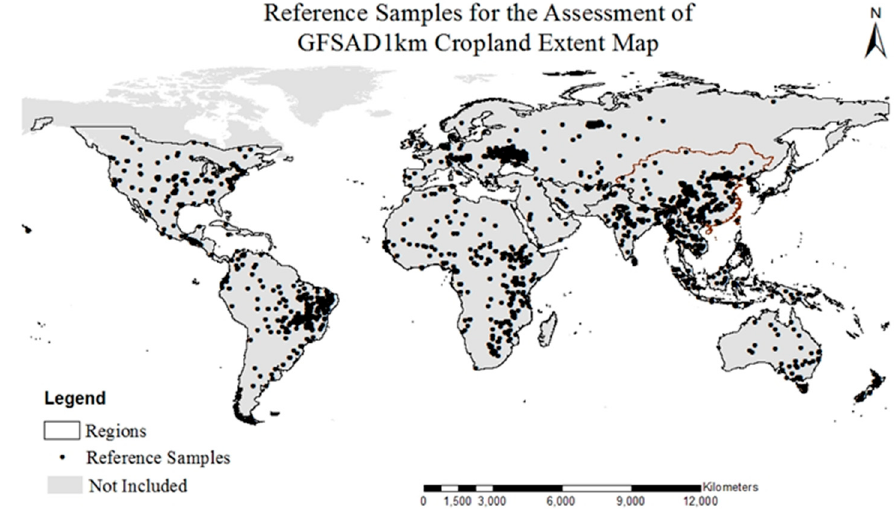
Figure 5. The distribution of eight regions along with the entire reference data of 1800 samples (Source: Geo-Wiki) used in the assessment of GFSAD1km cropland extent map. Table 6. Regions, their area, and number of samples (Source: GeoWiki) that were used to assess the GFSAD1km Cropland extent map.